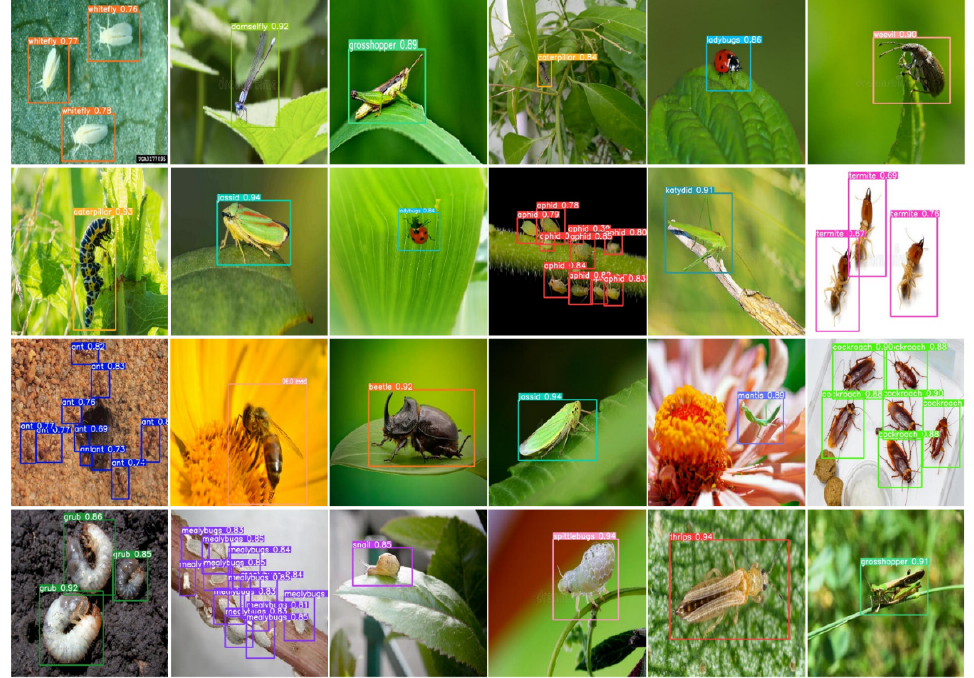
Figure 11. Detection results of YOLOv5x.